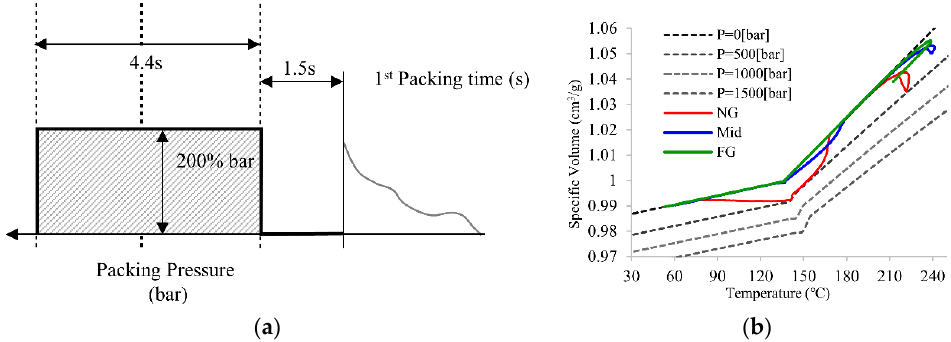
Figure 7. ( a ) Principle of intermittent packing pressure setup and ( b ) PVT processing path of principle of intermittent packing pressure setup for FG section.